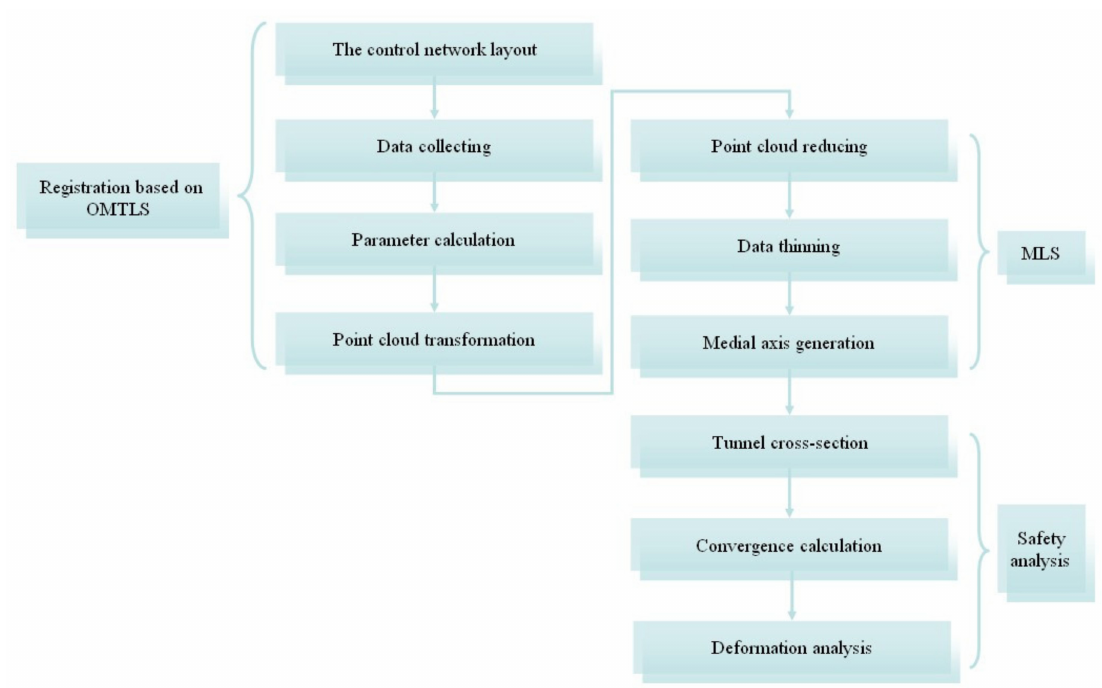
Figure 1. Flow diagram of the proposed